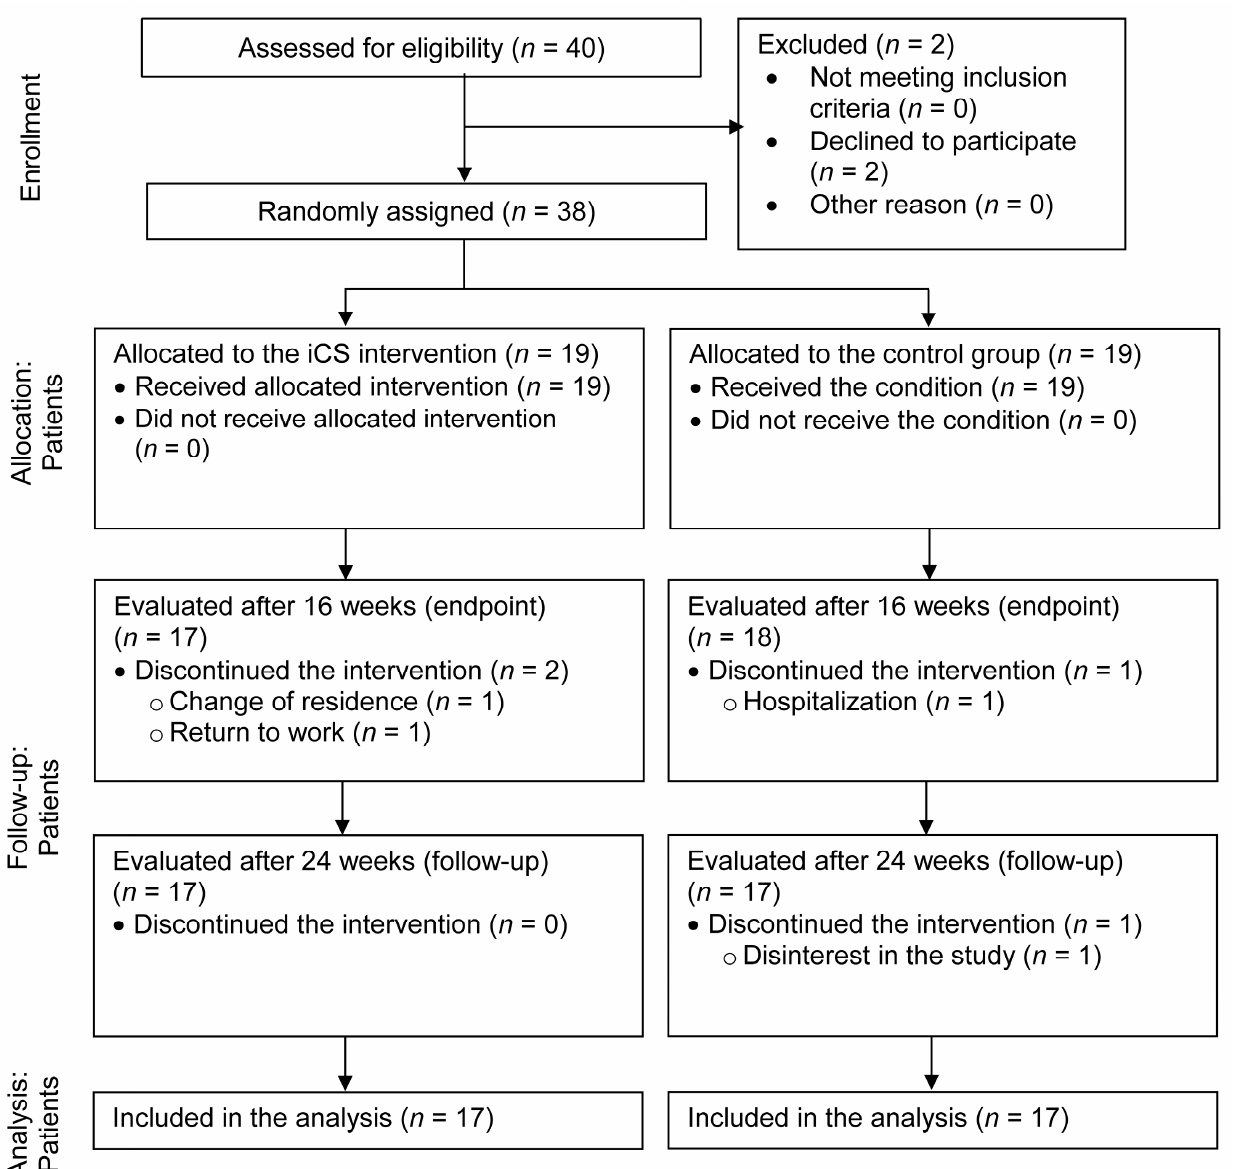
Figure 1. CONSORT diagram of participant flow through the study.